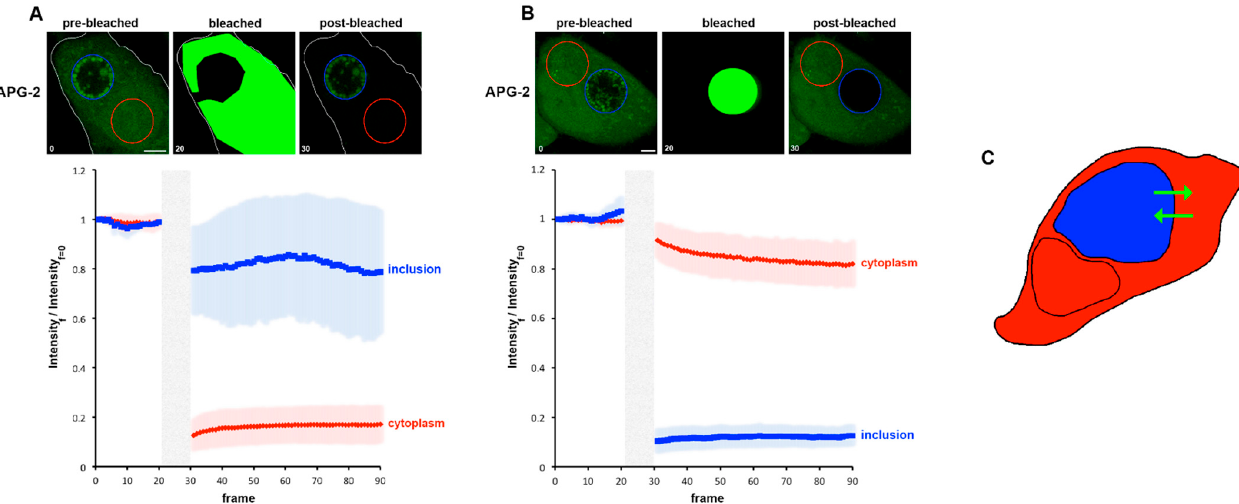
Figure 6. Fast movement of K + between the host cytoplasm and the inclusion. HeLa cells were infected with C. trachomatis LGV2. At 24 hpi cells were labelled with APG-2 and then imaged. APG-2 was bleached in the cytoplasm ( A ) or the inclusion ( B ), and imaged again using confocal microscopy, as represented in the upper panel where one cell is shown as a representative example. Circles represent regions of interest: inclusion (blue) and cytoplasm (red). Scale bar: 5 µm. On the lower panel, analysis of fluorescence intensities of the inclusion of cytoplasm are represented related to the frame number (a frame per 1.509 s). The light grey boxes represent the bleaching step. ( C ) Schematic of the result, the cell is depicted, and the cytoplasm is coloured in red while the inclusion is in blue. The green arrows represent the proposed K + movement.